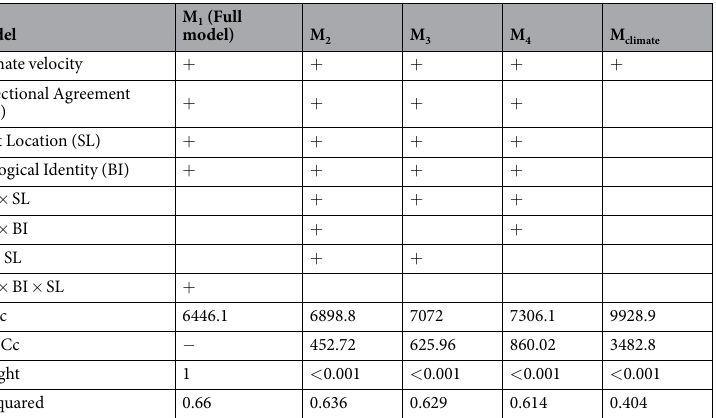
Table 2. Comparison of the climate-expectation Gamma (log-linked) GLMs for the prediction of shift responses ( n = 270) ranked in terms of AICc values (for information on the model coefficients, see Table S2). Models fit the fourth-root transformed observed shifts (km/decade) weighted by the number of observed years per observation on the fourth-root transformed climate velocity estimate (km/year) and the three-way interaction among biological identity, shift location, and directional agreement between thermal gradients and current flows. Selection was based on the Akaike Information Criterion corrected for finite sample sizes (AICc). The D-squared statistic denotes the proportion of total variance explained by the model and has an analogous interpretation to that of the coefficient of determination used in linear regression models. The results are presented for the first 4 ranked models and the climate-expectation model (i.e., using only climate velocity as a